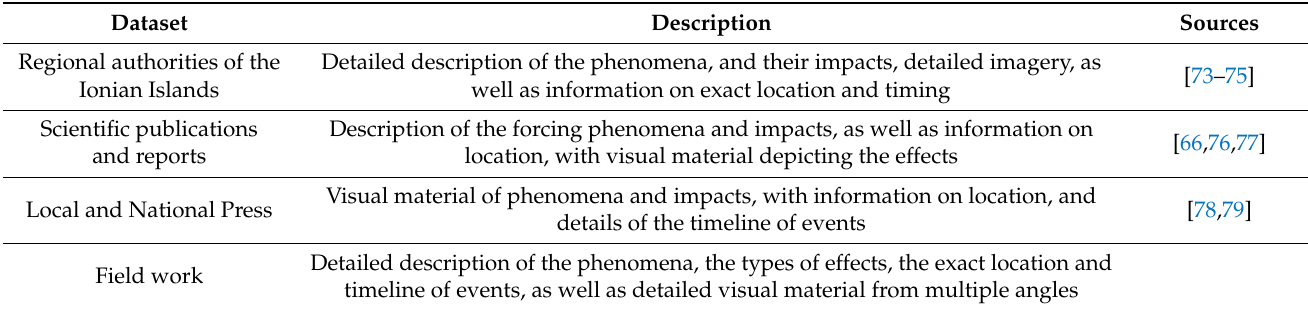
Table 1. Sources and detailed description of the data